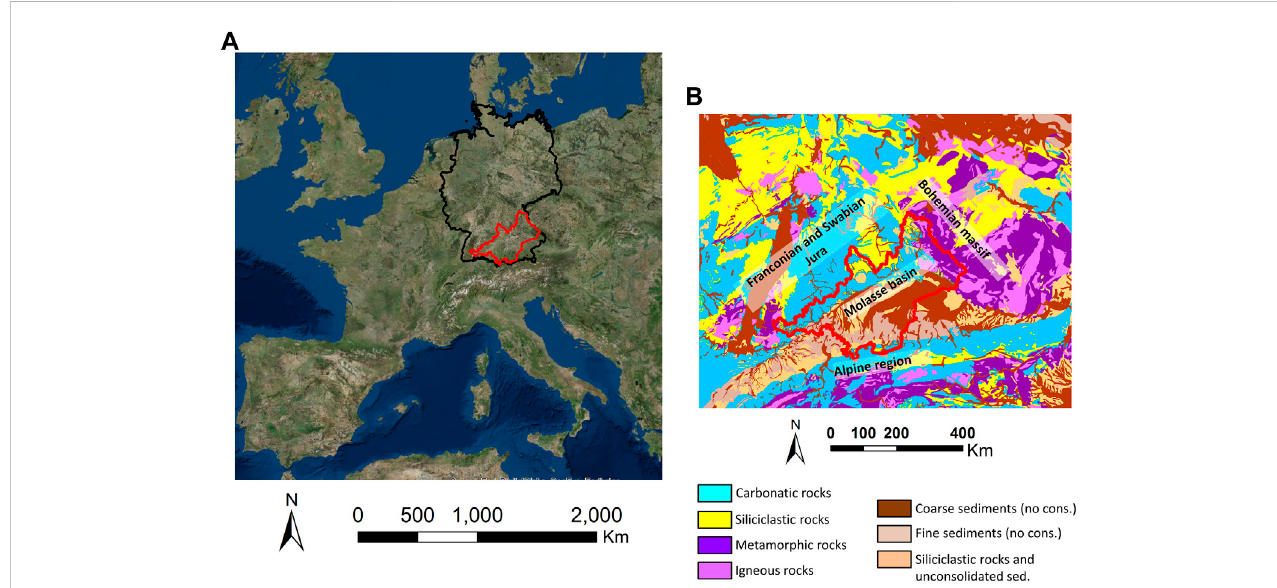
FIGURE 1 (A) Modelled area; (B) Main geological and geographical